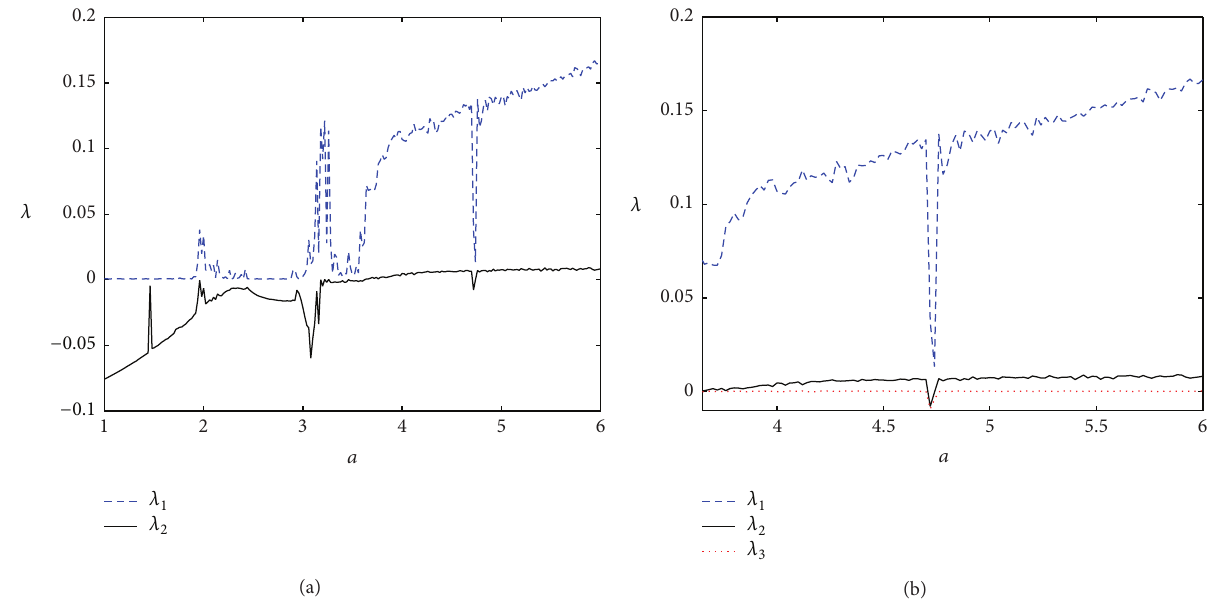
Figure 4: Lyapunov exponents of system (5) versus 𝑎 for 𝑏 = 0.001 , (a) two largest Lyapunov exponents 𝜆 1 , 𝜆 2 ; (b) three largest Lyapunov exponents 𝜆 1 , 𝜆 2 , and 𝜆 3 .